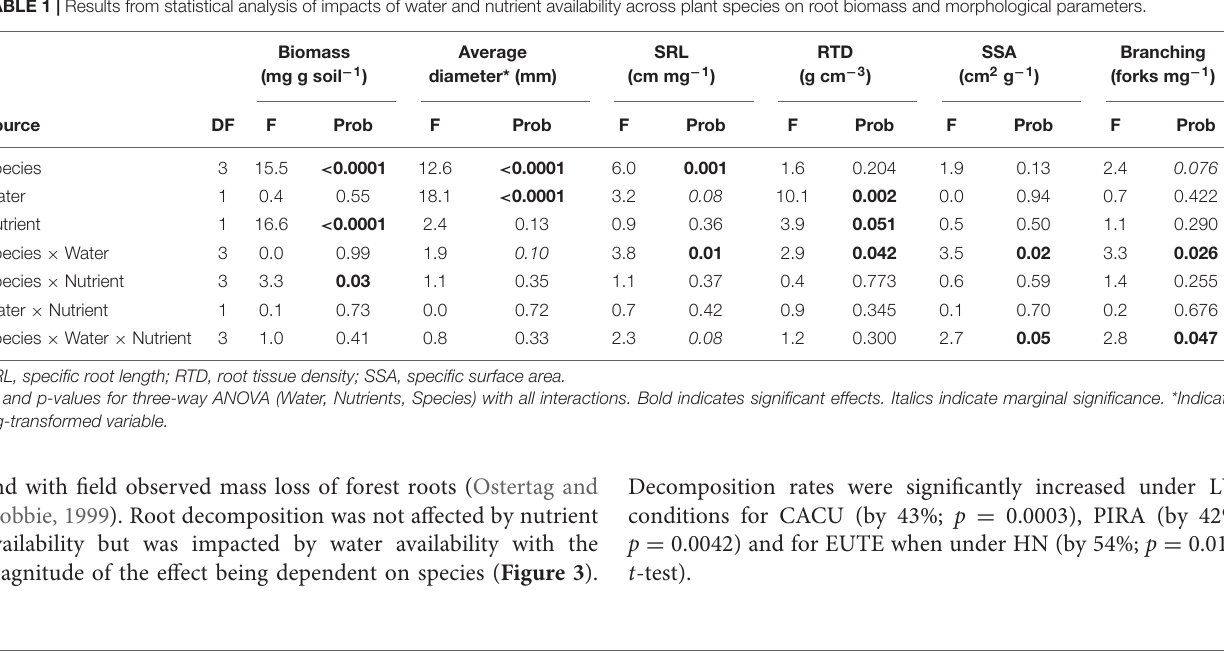
FIGURE 1 | Root biomass and morphological parameters in response to water and nutrient availability treatments. Water (W): Low/High water availability (LW/HW), Nutrients (N): Low/High nutrient availability (LN/HN). (A) Biomass; (B) diameter; (C) specific root length (SRL); (D) root tissue density (RTD); (E) specific surface area (SSA); (F) number of forks (branching points). Data points represent averages across shelters/replicates with standard error ( n = 6). P -values from two-way ANOVA with interactions for each species. Italics indicate marginal significance. See Table 1 for analysis across species. CACU, Casuarina cunninghamiana ; EUSI, Eucalyptus sideroxylon ; EUTE, Eucalyptus tereticornis ; PIRA, Pinus radiata . TABLE 1 | Results from statistical analysis of impacts of water and nutrient availability across plant species on root biomass and morphological